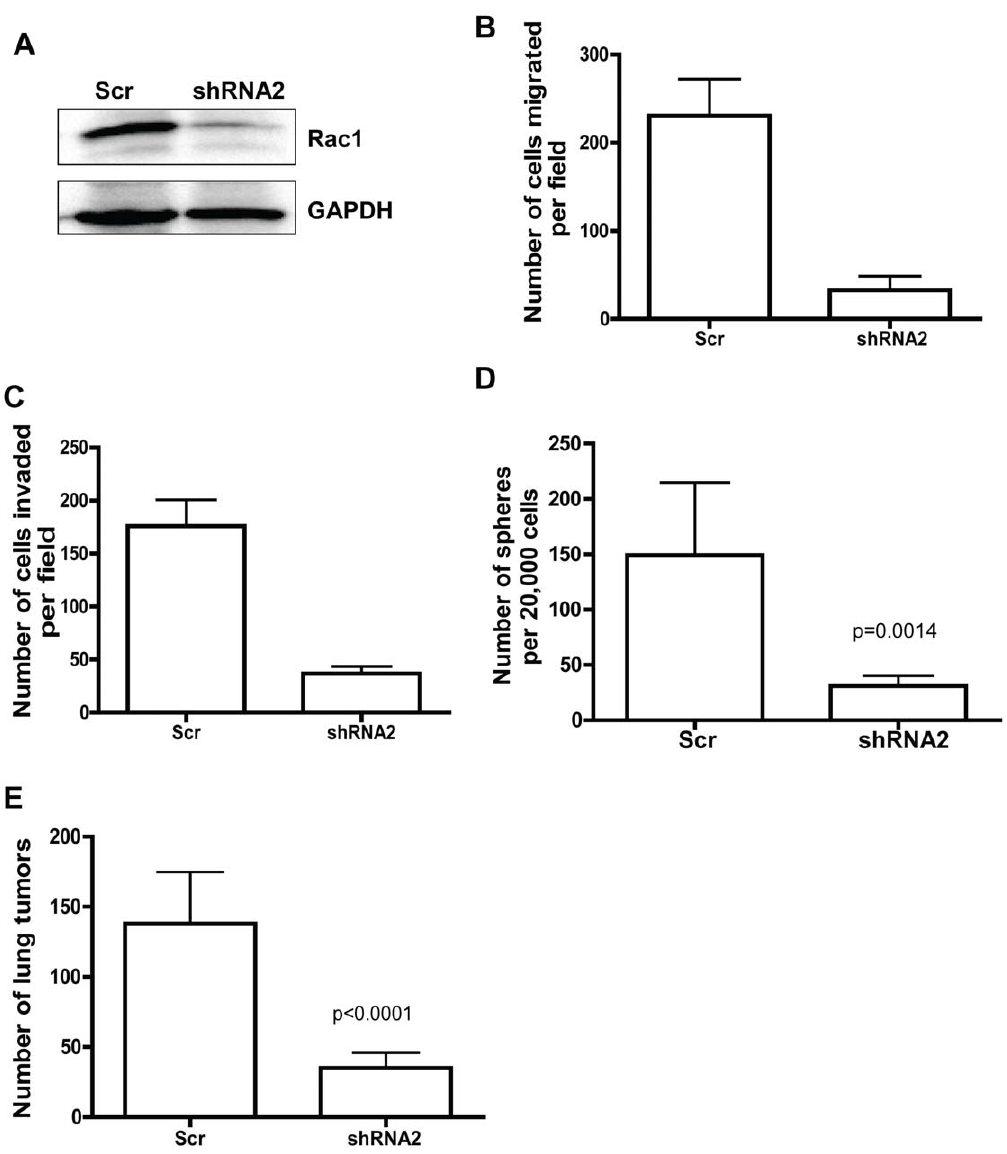
Figure 7. Rac1 targeting inhibits primary non-small cell lung cancer cell migration, invasion, sphere forming and lung colonization activities. (A) Cells isolated from primary tumor sample were infected with either scr or Rac1 shRNA and sorted cells were subjected to Rac1 western blot analysis. GAPDH was used as loading control. Above depicted is a representative of multiple western blots. (B, C, D) Primary human adenocarcinoma cells were plated for either trans-well migration assay (B) or invasion assay (C) or sphere assay (D). For sphere assay, sorted cells were directed plated in sphere growth media described in methods section. Number of spheres formed after 10 days were counted using light microscope. All the assays were performed in triplicates and error bar represents SD. Results are representative of three independent experiments. (E) For lung colonization assay, 5 6 10 5 sorted cells were injected into tail vein of NSG mice (n=4 per condition) and mice were sacked after 6 weeks. Number of lung tumors was counted under dissecting microscope. Error bar represents SD.